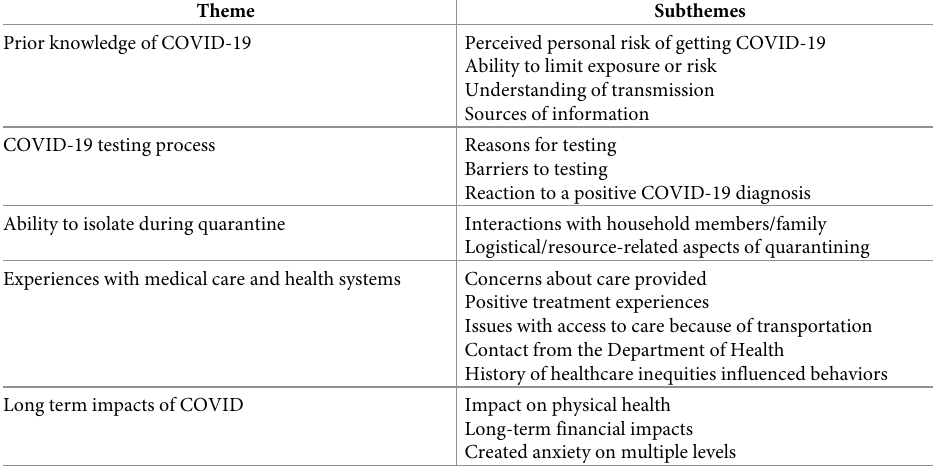
Table 2. Interview themes and subthemes.